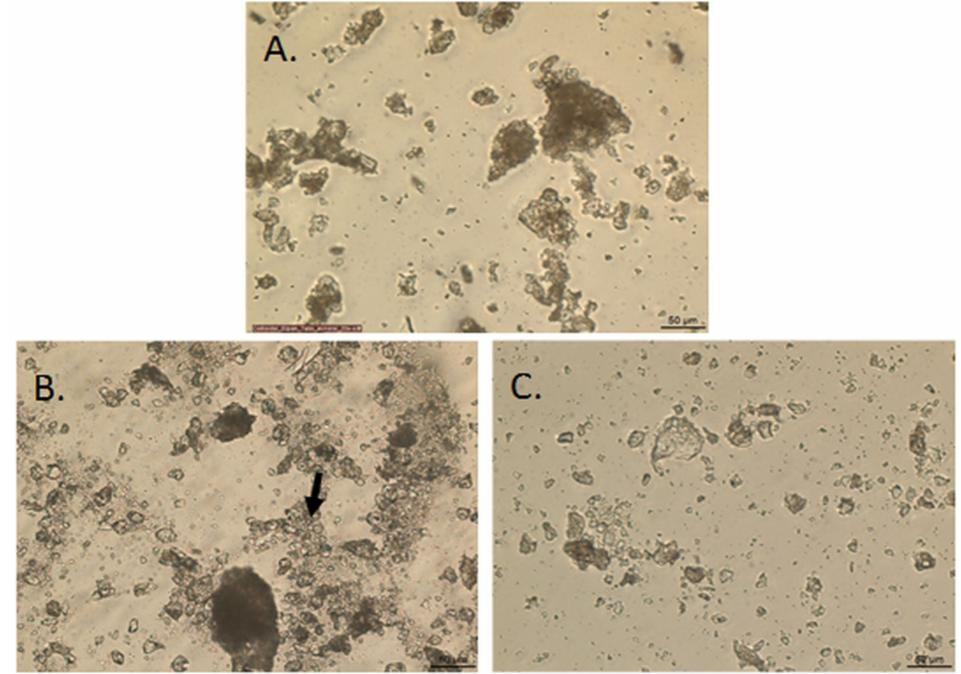
Figure 1. Optic microphotographs of Bismuth Oxide 120 mg FC Tabs as received after film re- moval ( A ), after treatment with acetonitrile ( B ), and after treatment with acetonitrile and subsequent treatment with heated DMSO ( C ) using 20 × magnification objective